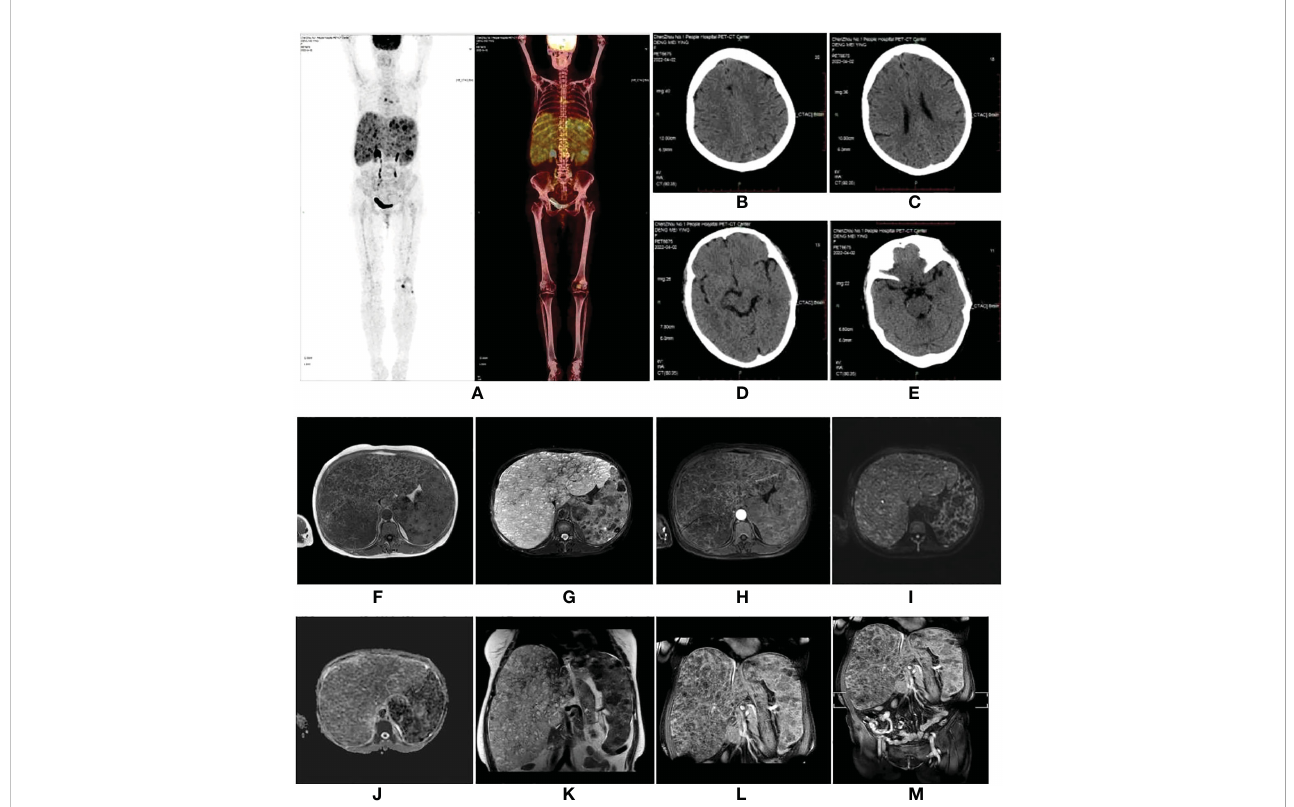
FIGURE 1 (A – E) Fluorodeoxyglucose positron emission tomography (FDG-PET) scan performed at the local hospital. The images showed diffuse hepatomegaly and splenomegaly with a slightly increased FDG uptake, without other abnormal FDG accumulation or intracranial lesions. (F – M) A magnetic resonance imaging scan of the abdomen revealed hepatosplenomegaly with countless nodules of various sizes involving the whole liver and spleen, which showed hypointensity on T1-weighted (T1W) images (F) , hyperintensity on T2-weighted (T2W) images (G) , and inhomogeneous enhancement in diffusion MRI